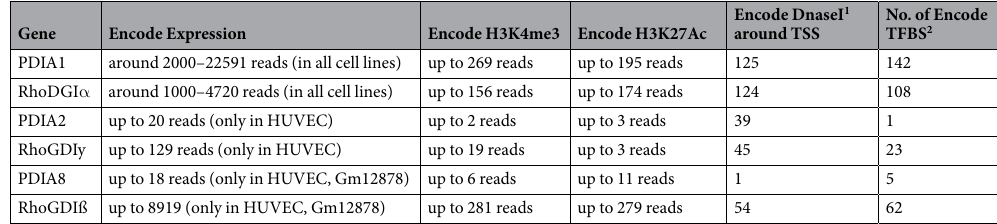
Table 3. Analysis of transcription, H3K4me3/H3K27Ac histone modifications, DNaseI sites and number of transcription factors according to ENCODE. 1 DnaseI sites quantification around transcriptional start